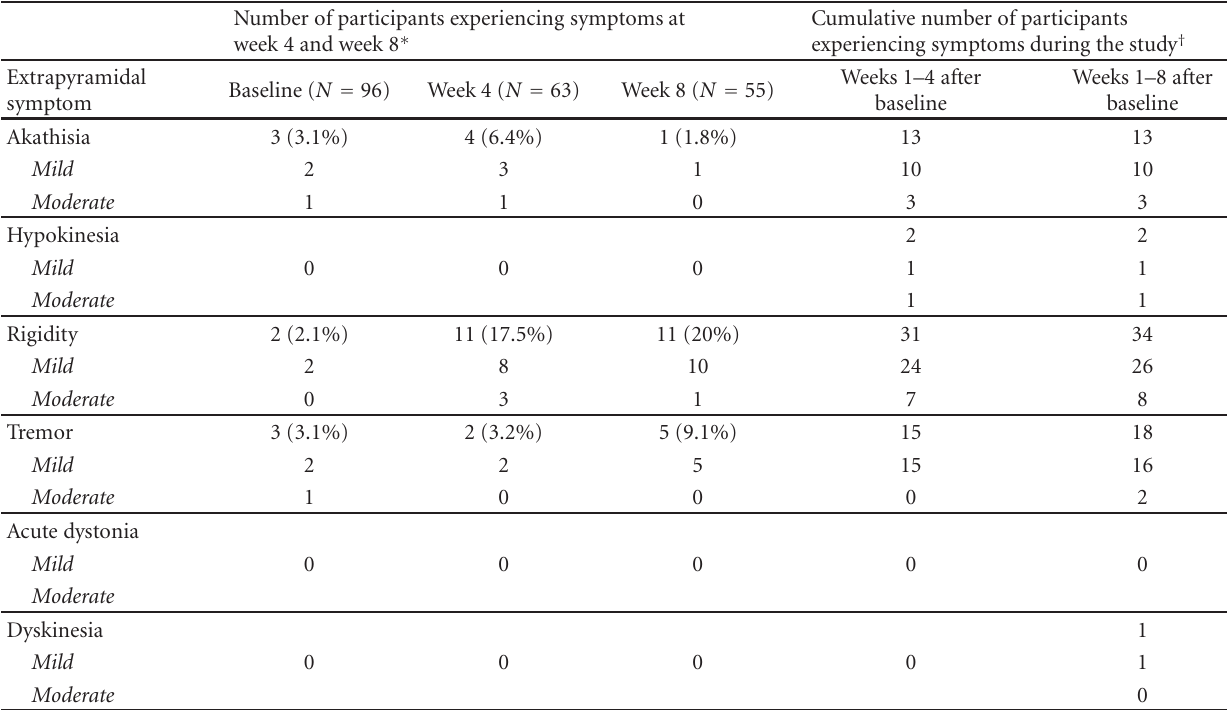
Table 3: Summary of the reports of extrapyramidal